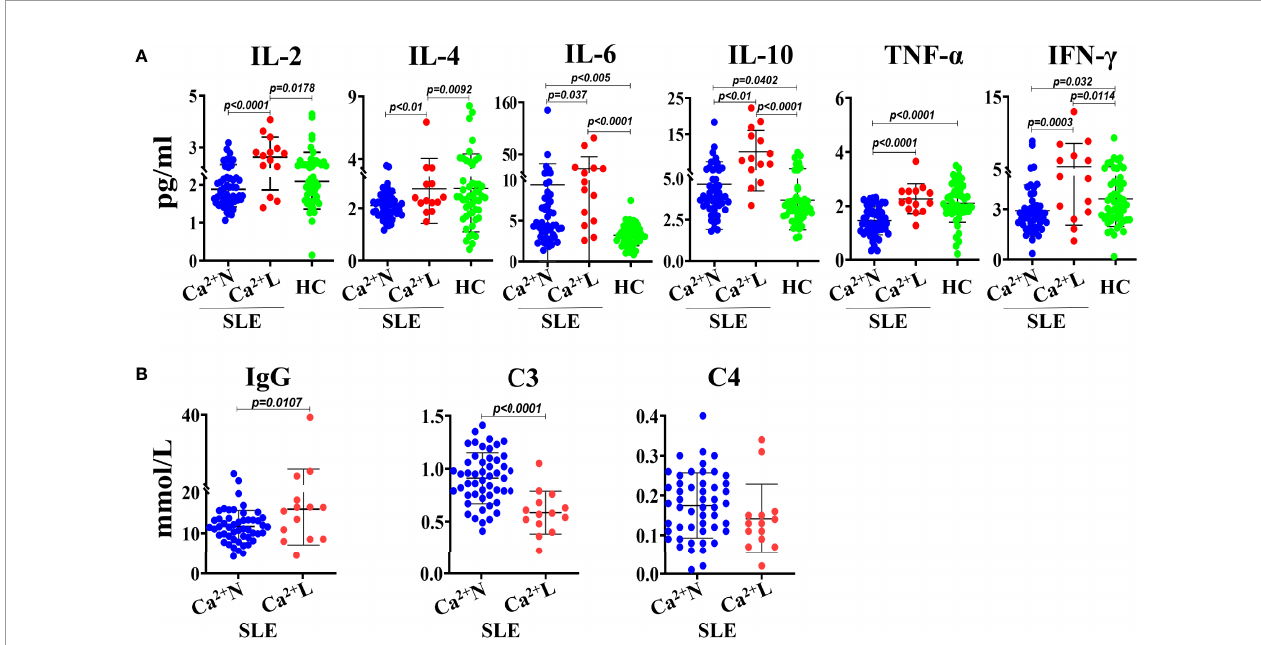
FIGURE 2 | The levels of Th1/Th2 cytokines, IgG and complements in sera of SLE patients with or without hypocalcemia. The Th1/Th2 cytokines in sera of SLE patients (n=64) and healthy people (n=50) were detected by CBA. The concentrations of serum IgG and complements come from the routine test data. (A) The serum levels of Th1/Th2 cytokines. (B) The serum concentrations of IgG and complements of C3 and C4. Each point in the scatter plot represents a person ’ s data, and the black line shows the mean